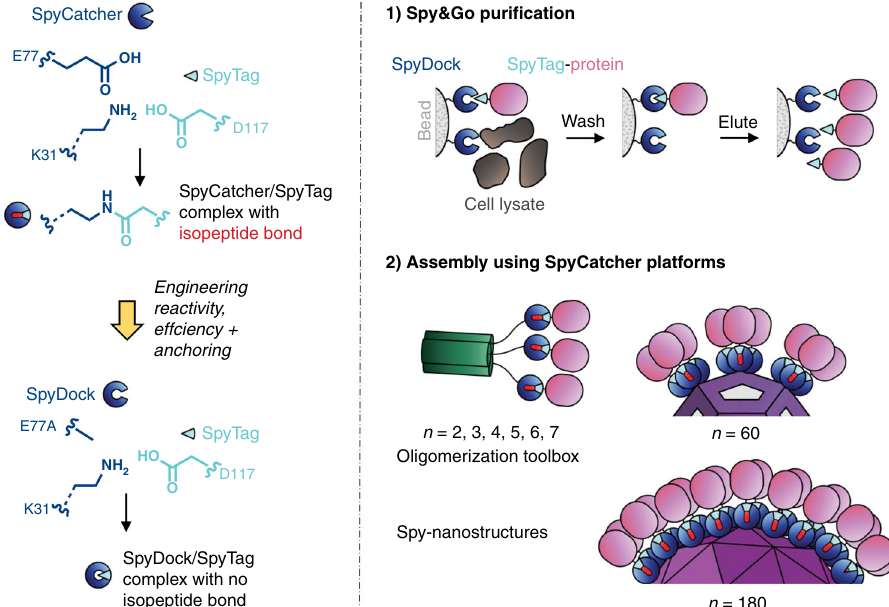
Fig. 1 Overview of Spy&Go. SpyTag/SpyCatcher interact irreversibly by spontaneous isopeptide bond formation, promoted by E77. SpyTag puri fi cation requires the generation of reversible interaction with SpyDock in 3 steps: blocking reaction, enhancing ef fi ciency of SpyTag binding and precise immobilization on resin. Spy&Go then enables puri fi cation of SpyTag-fusions, setting the stage for modular oligomerization or